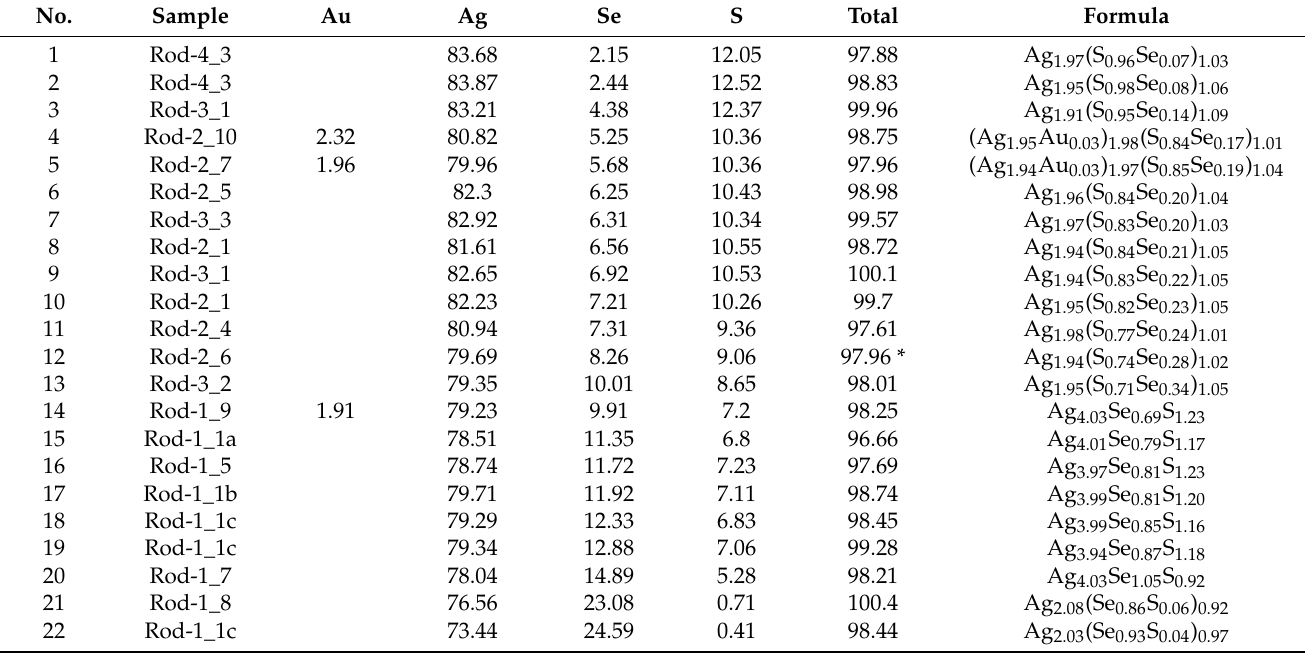
Table 4. Compositions and empirical formulae of acanthite, aguilarite and naumannite, wt.%.